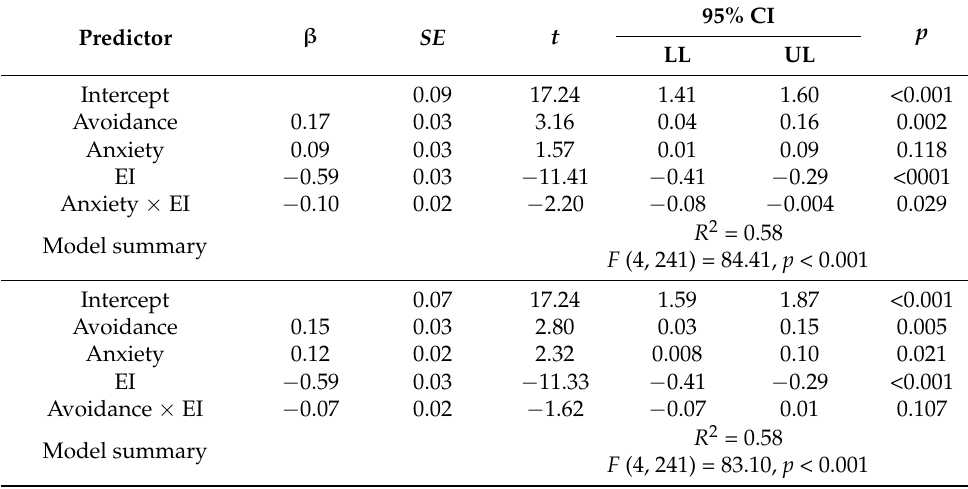
Table 7. Moderation analysis for Study 1.